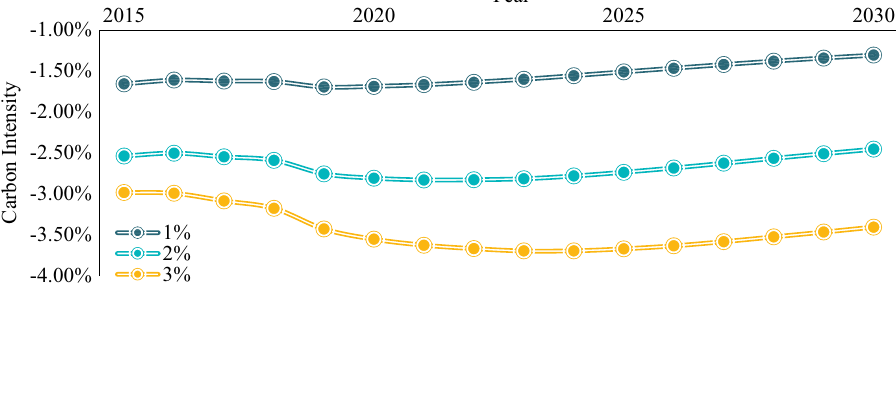
Fig. 7 The ITC impact on the RGDP loss